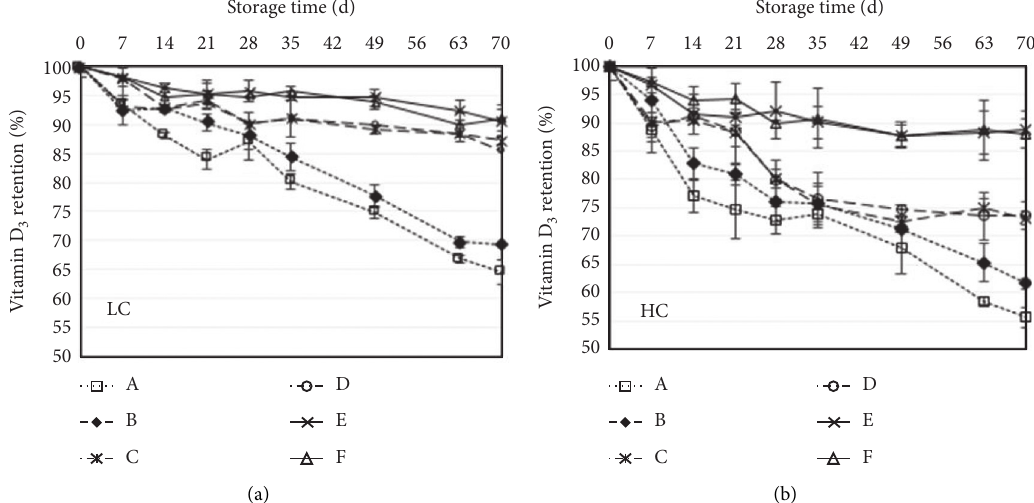
Figure 1: Evolution of vitamin D 3 retention in the fortified oils during storage. A: samples stored in transparent bottles at room temperature with filling level of 50%; B: samples stored in transparent bottles at room temperature with filling level of 100%; C: samples stored in dark- brown bottles at room temperature with filling level of 50%; D: samples stored in dark-brown bottles at room temperature with filling level of 100%; E: samples stored in dark-brown bottles at 4 ° C with filling level of 50%; F, samples stored in dark-brown bottles at 4 ° C with filling level of